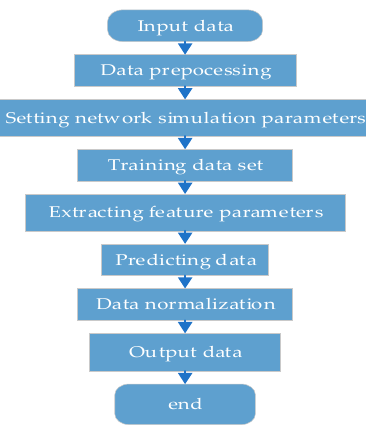
Figure 4. Wind speed prediction flow chart based on LSTM model.